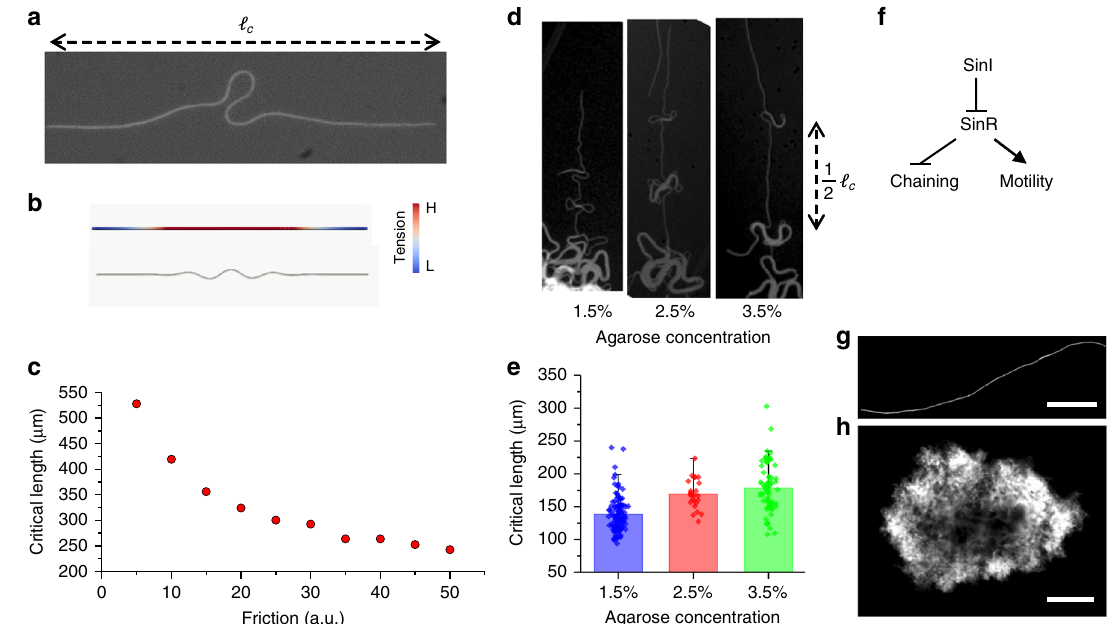
Fig. 2 Localized buckling of a bacterial chain. a A snapshot of a bacterial chain with a length just above the critical buckling length. The buckled region is highly localized due to b localization of stress generated by the uniform friction force. The stress accumulates from the tip to the center of the chain due to outward axial velocity. The uniform friction force creates an almost linear stress distribution along the chain. The snapshots of the simulation before and after the buckling. Color code shows the tension at the pre-buckling stage. c Plot of the critical buckling length against friction, simulation results. d Successive localized buckling instabilities at 1.5%, 2.5%, and 3.5%, respectively. After the fi rst buckling, the subsequent buckling occurs at the middle of the straight part of the chain, which implies that the stress is symmetric around the center, and the connection of the former buckling region with the straight part is effectively a free end. Therefore, the separation between buckled regions is equal to half of the critical buckling length. e Experimental results of the critical buckling length for various agarose concentrations. The data are collected from more than 100 chains. Error bars are de fi ned as s.d. f Schematic of a simpli fi ed regulatory network that controls the bio fi lm formation. The protein sinI regulates the chaining state through double-negative feedback. g, h Bacterial chain grown in liquid LB. g The chaining formation is initiated by IPTG induction. h In the later stages, the colony forms a bio fi lm via supercoiling. Scale bar, 50 and 200 μ